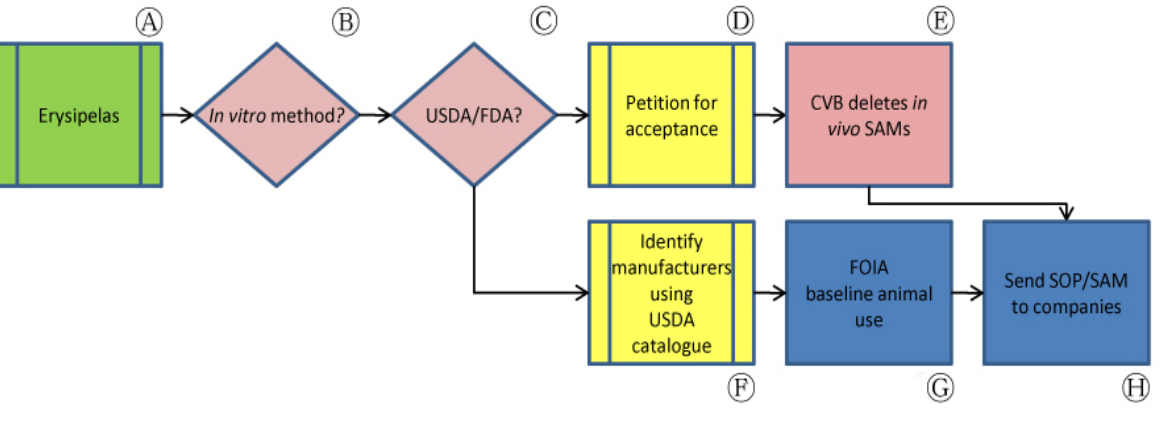
Figure 2. Application of the bridging paradigm to erysipelas vaccine potency testing in the United